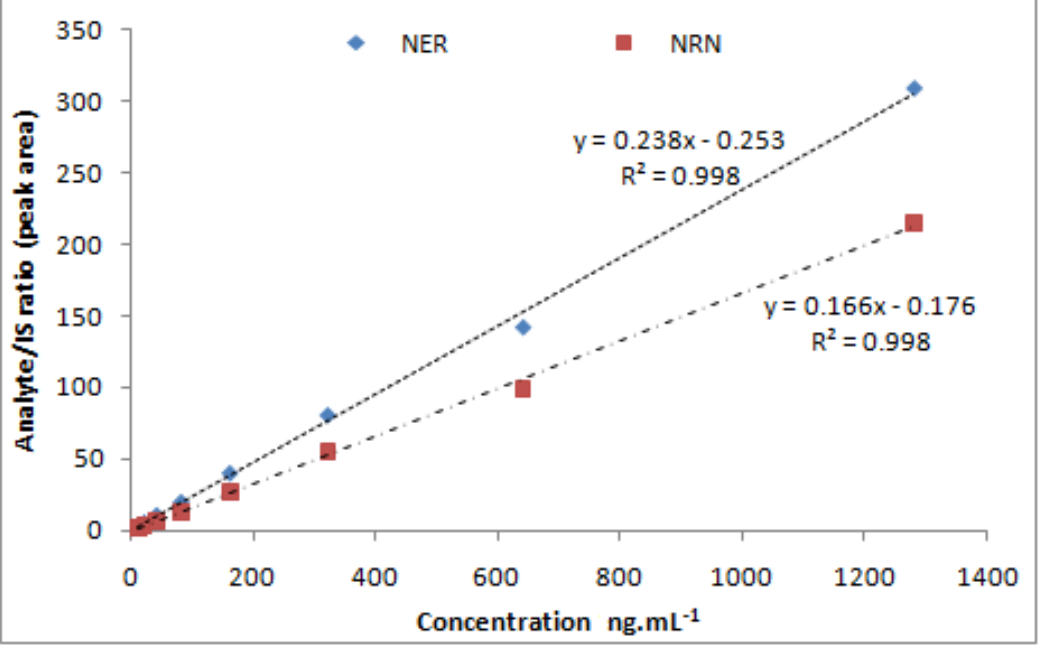
Figure 3. Calibration curve of NER and NRN. Table 2. Method trueness and precision